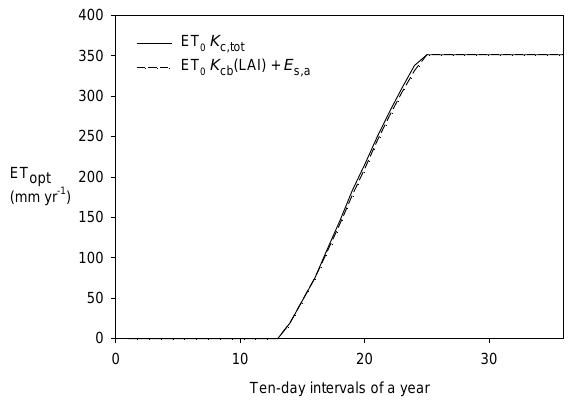
Fig. B2 Fig. B2. Cumulative total evapotranspiration of unstressed potato (ET opt ) calculated with Feddes-factor multiplied by ET 0 , and cal- culated with K cb (LAI) multiplied by ET 0 plus the actual soil evap- oration E s,a , per ten-day interval, averaged over 30yr (1971–2000).